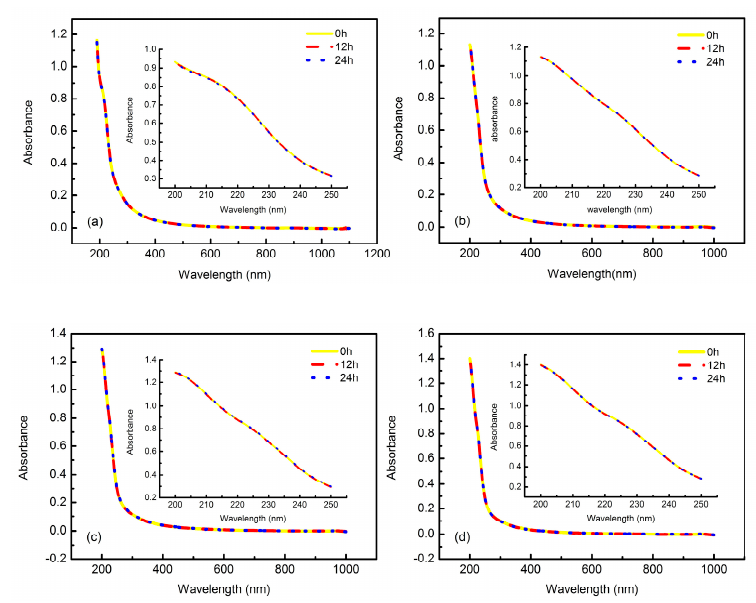
Figure 4. Correlation between absorbance of latex and time: ( a ) 0%, ( b ) 1%, ( c ) 2%, and ( d ) 3%.